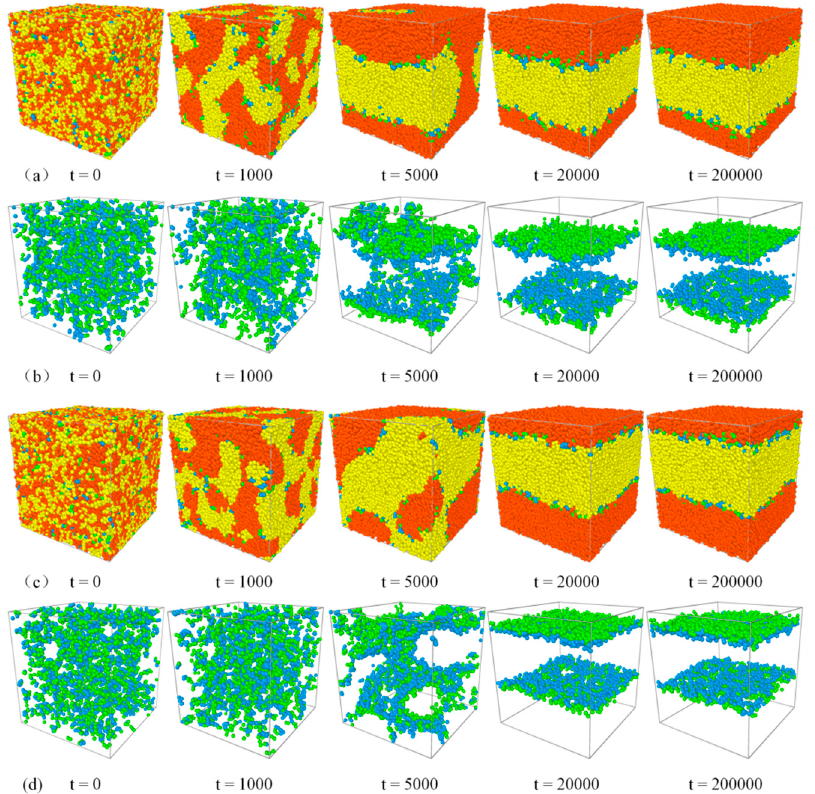
Figure 1. Representative morphology snapshots for ternary mixtures at different simulation times. Compositions are A 8 / A 4 B 4 / B 8 for ( a , b ), and A 8 / A 2 B 4 A 2 / B 8 for ( c , d ). Concentration of the copolymer is fixed as c cp = 0.05. Red and yellow spheres represent bead A and bead B of homopolymers, and green and blue spheres represent beads A and B of the copolymers.